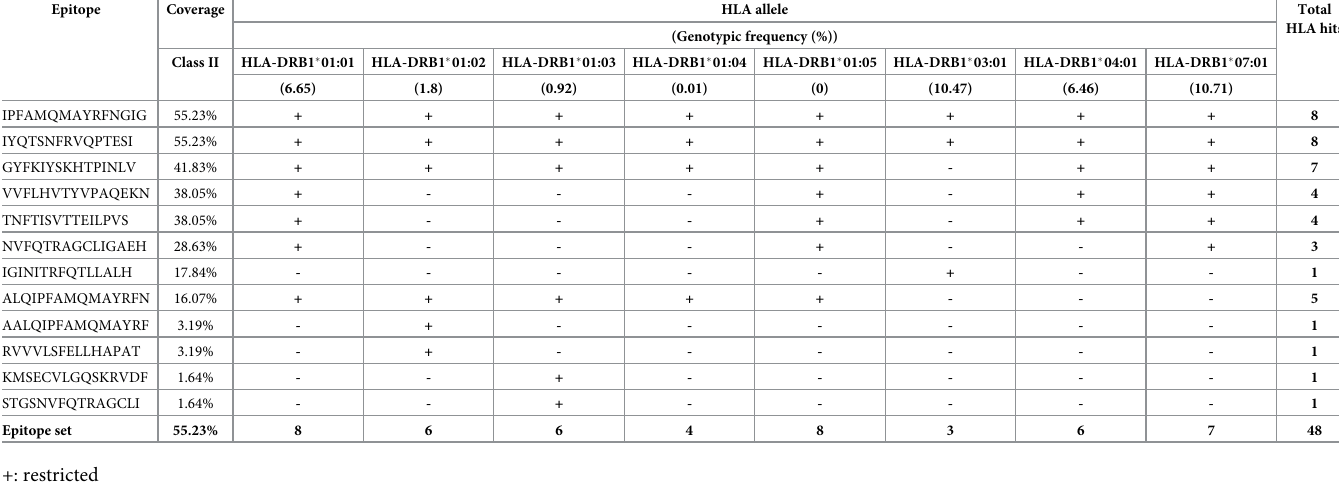
Table 6. Coverage of individual epitope (MHC class II) in the world. Epitope Coverage HLAallele Total